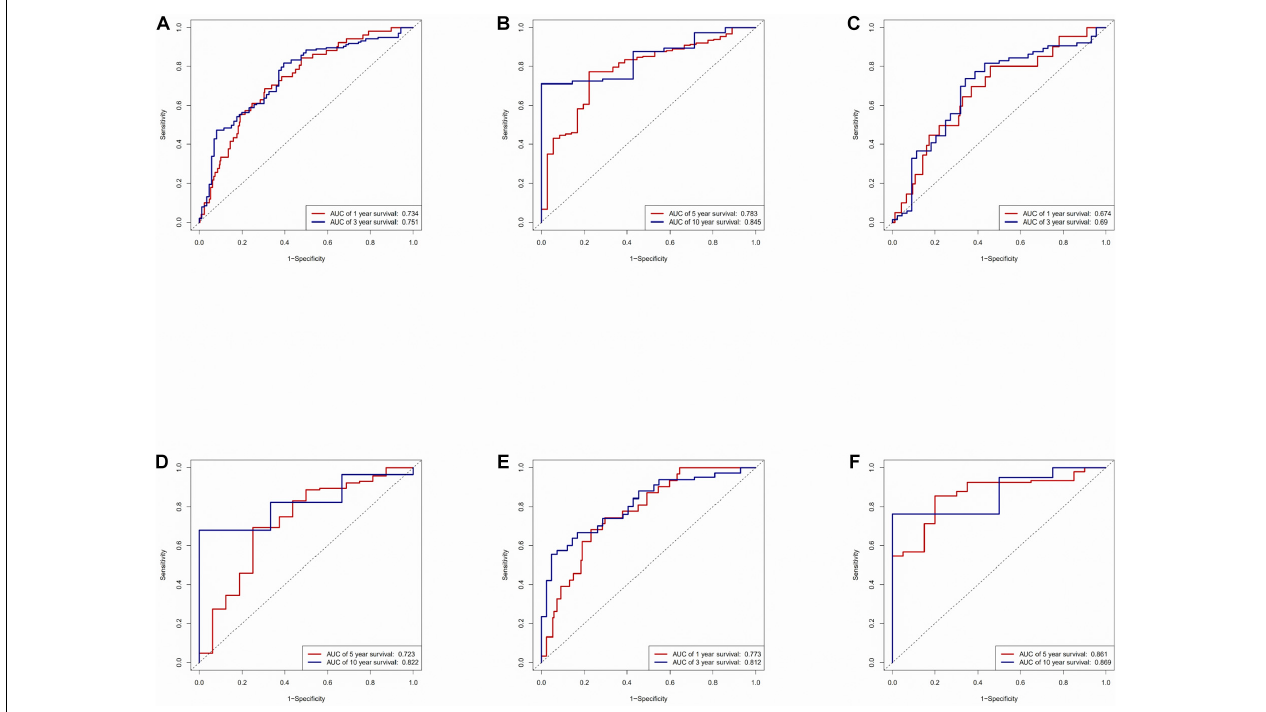
FIGURE 3 | Time-ROC curve analysis of risk model. (A) Time-ROC curve analysis of the immune-related lncRNA signature in the TCGA dataset in 1, 3-year. (B) Time-ROC curve analysis of the immune-related lncRNA signature in the TCGA dataset in 5, 10-year. (C) Time-ROC curve analysis of the immune-related lncRNA signature in the testing set in 1, 3-year. (D) Time-ROC curve analysis of the immune-related lncRNA signature in the testing set in 5, 10-year. (E) Time-ROC curve analysis of the immune-related lncRNA signature in the training set in 1, 3-year. (F) Time-ROC curve analysis of the immune-related lncRNA signature in the training set in 5,